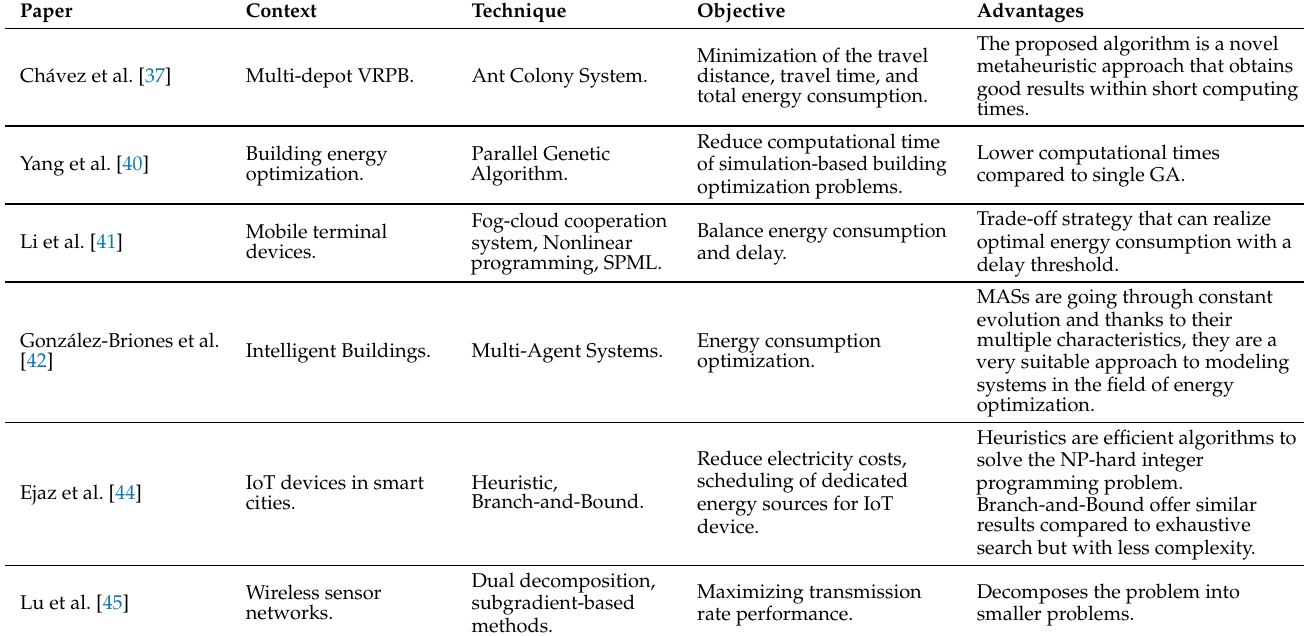
Table 1. Summary of optimization techniques used in different